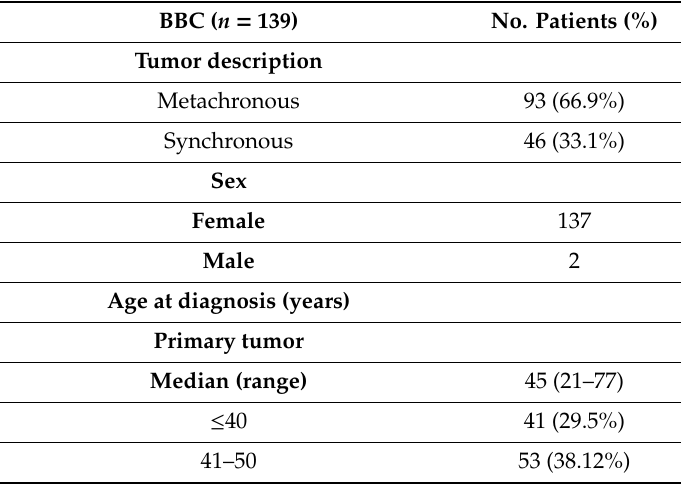
Table 1. Clinical characteristics of bilateral breast cancer